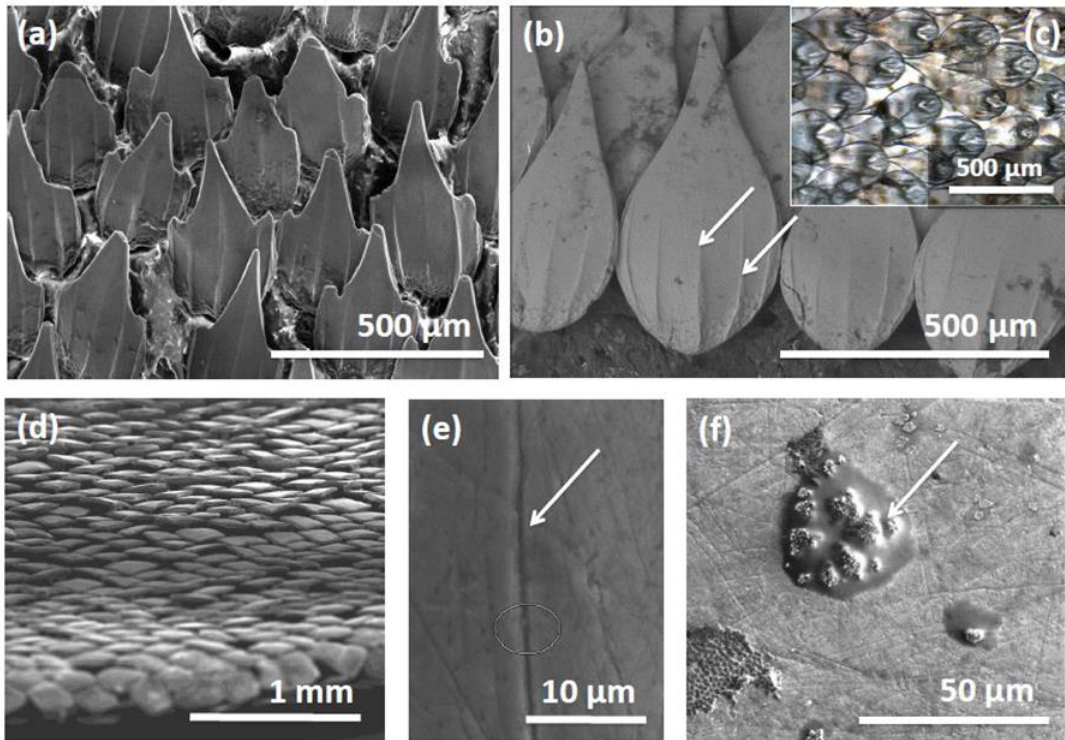
Figure 5. The shape and structure of dermal denticles from the small catshark, Scyliorhinus canicula (examined using electron microscopy). (( a , b ) scale bar = 500 µ m) Variations in the shape of dermal denticles observed from skin samples in different body locations in one individual specimen of this species. Similar structures to the microscopic ridges on the surface of individual denticles (as indicated by arrows in ( b ), scale bar = 500 µ m) are thought to be responsible for drag reduction in sharks. It is interesting to observe the degree of overlap between denticles (inset ( c ), scale bar = 500 µ m) and how the denticles extend and completely envelope the shark, including the trailing edges of fin surfaces ( d ), scale bar = 1 m)m. The role these structures play in both drag reduction and in antifouling is still of keen research interest. An interesting observation from close examination of denticle surfaces in S. canicula is that the upper surface of individual denticles are often scarred and grooved with microscopic ridges ( e ), scale bar = 10 µ m) perhaps from contact with other sharks or other behaviours that remove attached organisms, although fouling may be observed in some regions ( f ) scale bar = 50 µm.